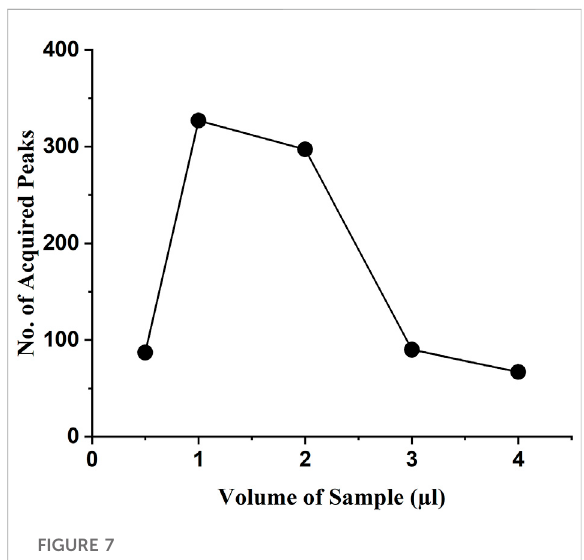
FIGURE 7 Average peak values were obtained using samples with different